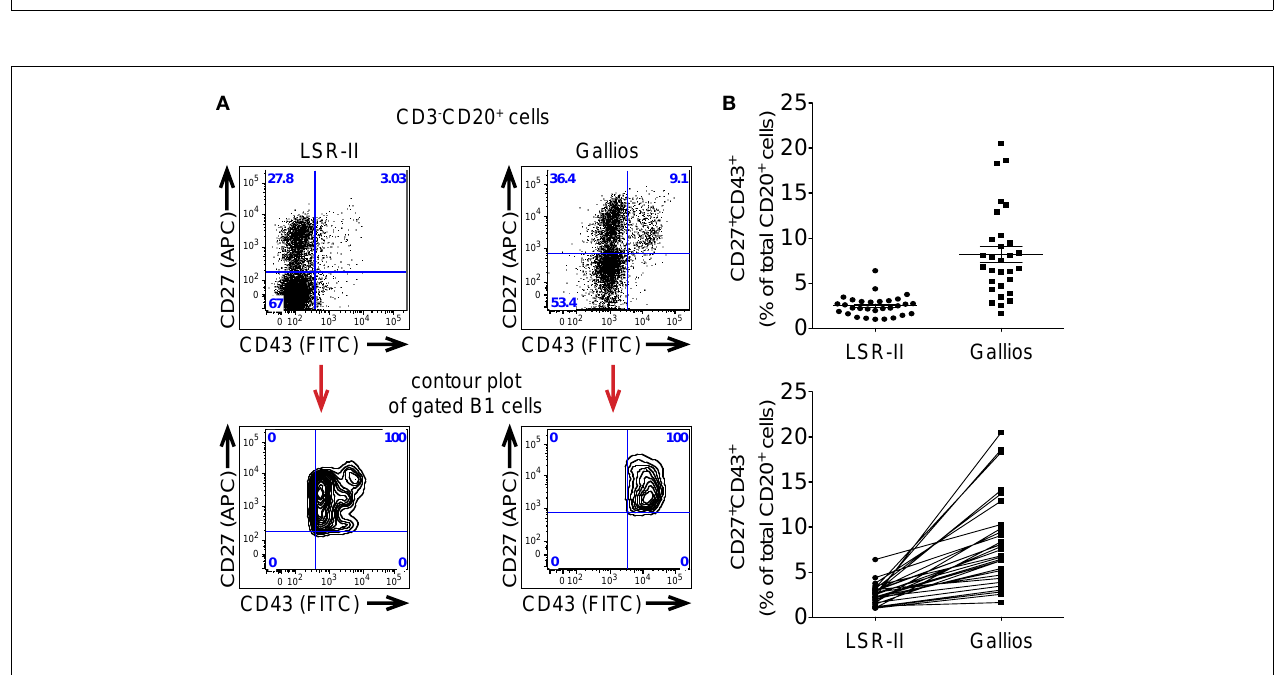
strategy used to separate CD3 − CD20 + CD27 − CD43 − (naive B cells), CD3 − CD20 + CD27 + CD43 − (memory B cells), and CD3 − CD20 + CD27 + CD43 + (B1 cells) for a typical adult blood sample is shown along with the FMO controls that were used to determine the gates for CD27 and CD43 positivity.